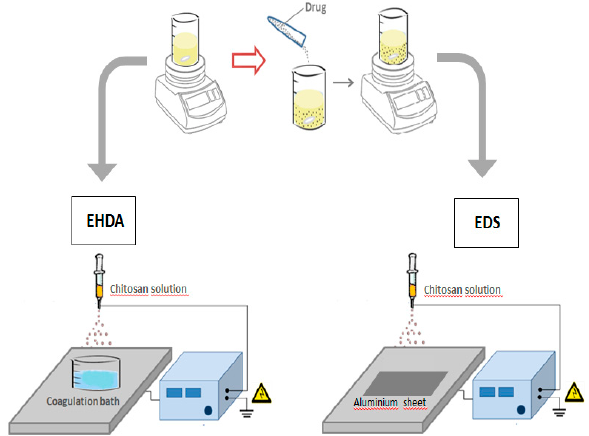
Figure 1. Schematization of EHDA and EDS processes for the fabrication of chitosan based microgels and nanoparticles.